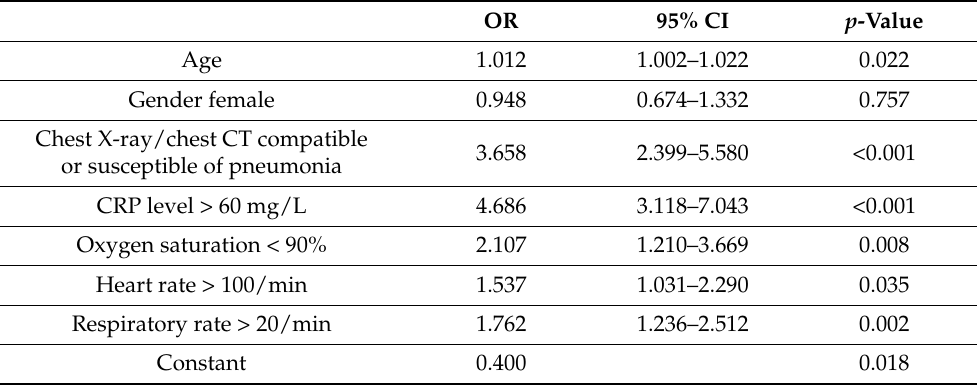
Table 4. Results of potentially factors influencing initiation of antibiotic treatment (outcome) by logistic